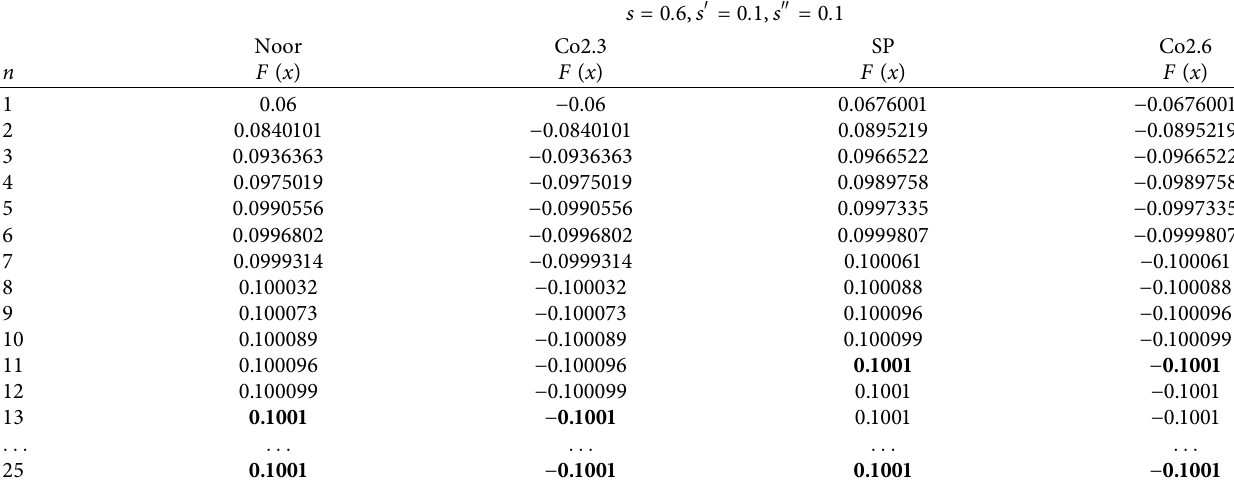
Table 5: Iterations of biquadratic function s � 0 . 6 ,s ′ � 0 . 1 ,s ″ � 0 .